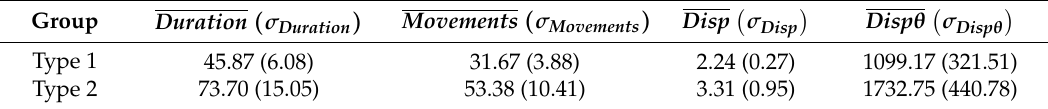
Table 9. Comparison of the results of groups Type 1 and Type 2. Each column represents the average and standard deviations for each variable on both groups. Type 1, has individuals with higher dexterity, as they used less time to complete the exercise, made fewer movements, and had smaller displacements. Type 2, include volunteers who have lower dexterity as the values of parameters were higher.